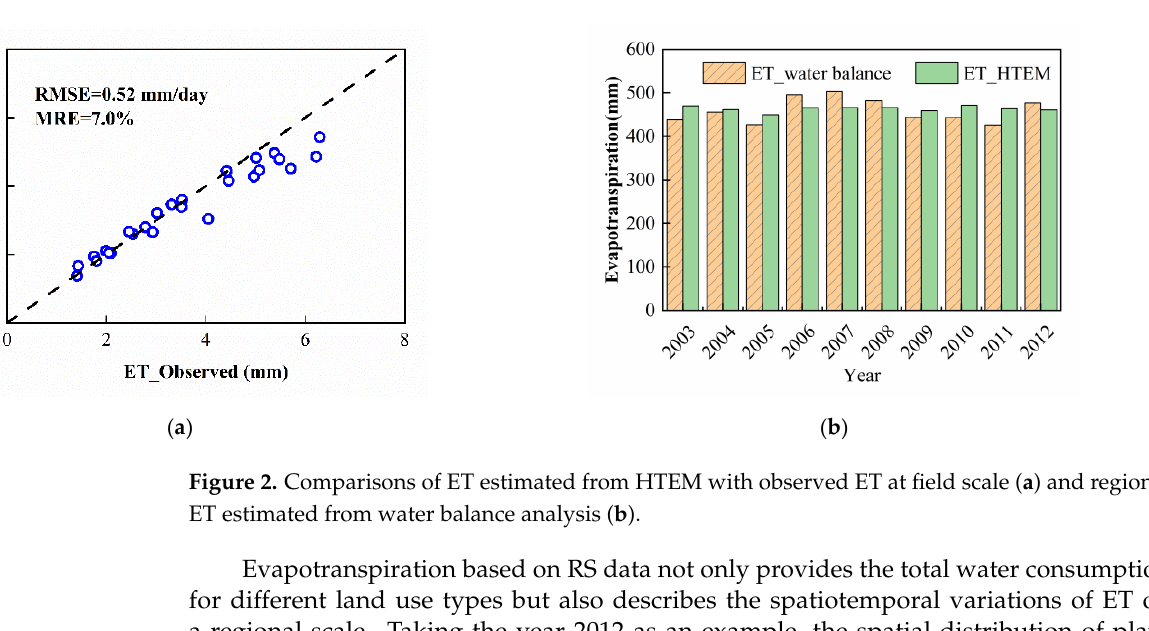
( b ) Figure 4. Mean NDVI series for sampled points and fitted asymmetric logistic function in 2012 ( a ) and the developed ellipse classifier ( b ).